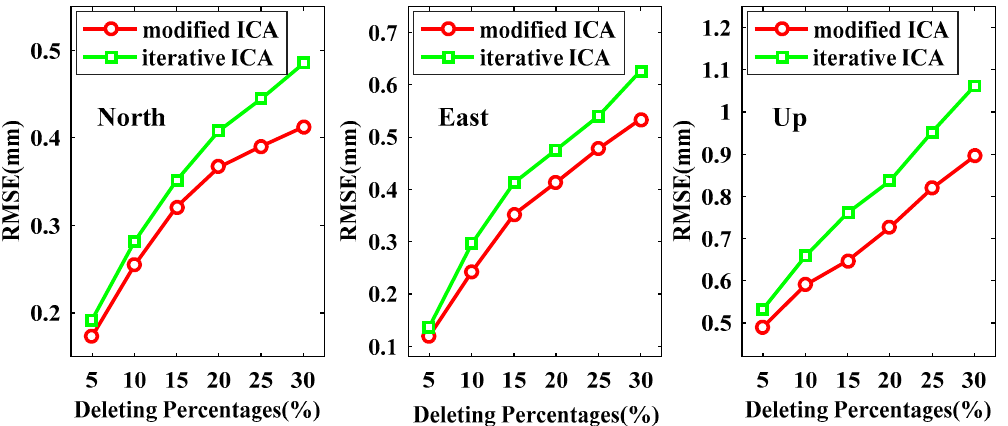
Figure 8. Root mean square errors (RMSEs) of the reconstructed signals derived from modified ICA and iterative ICA at all available data points.